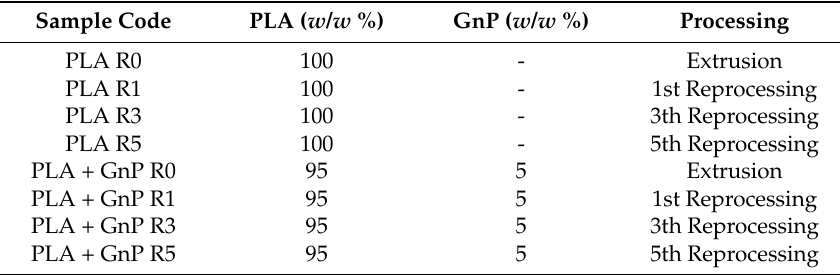
Table 1. Composition of samples and their